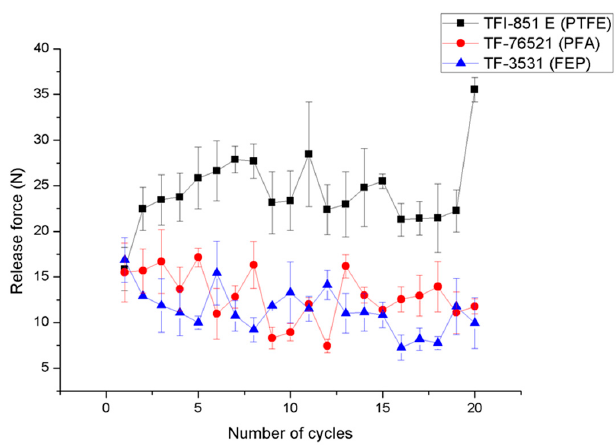
Figure 7. Release force of PUR foam on a flat surface of 45 × 45 mm 2 as a function of the foam cycles analyzed. Fluoropolymer coatings.